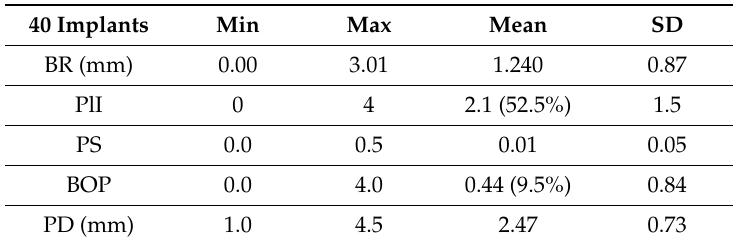
Table 3. Peri-implant health parameters (CBP implants, n = 40).